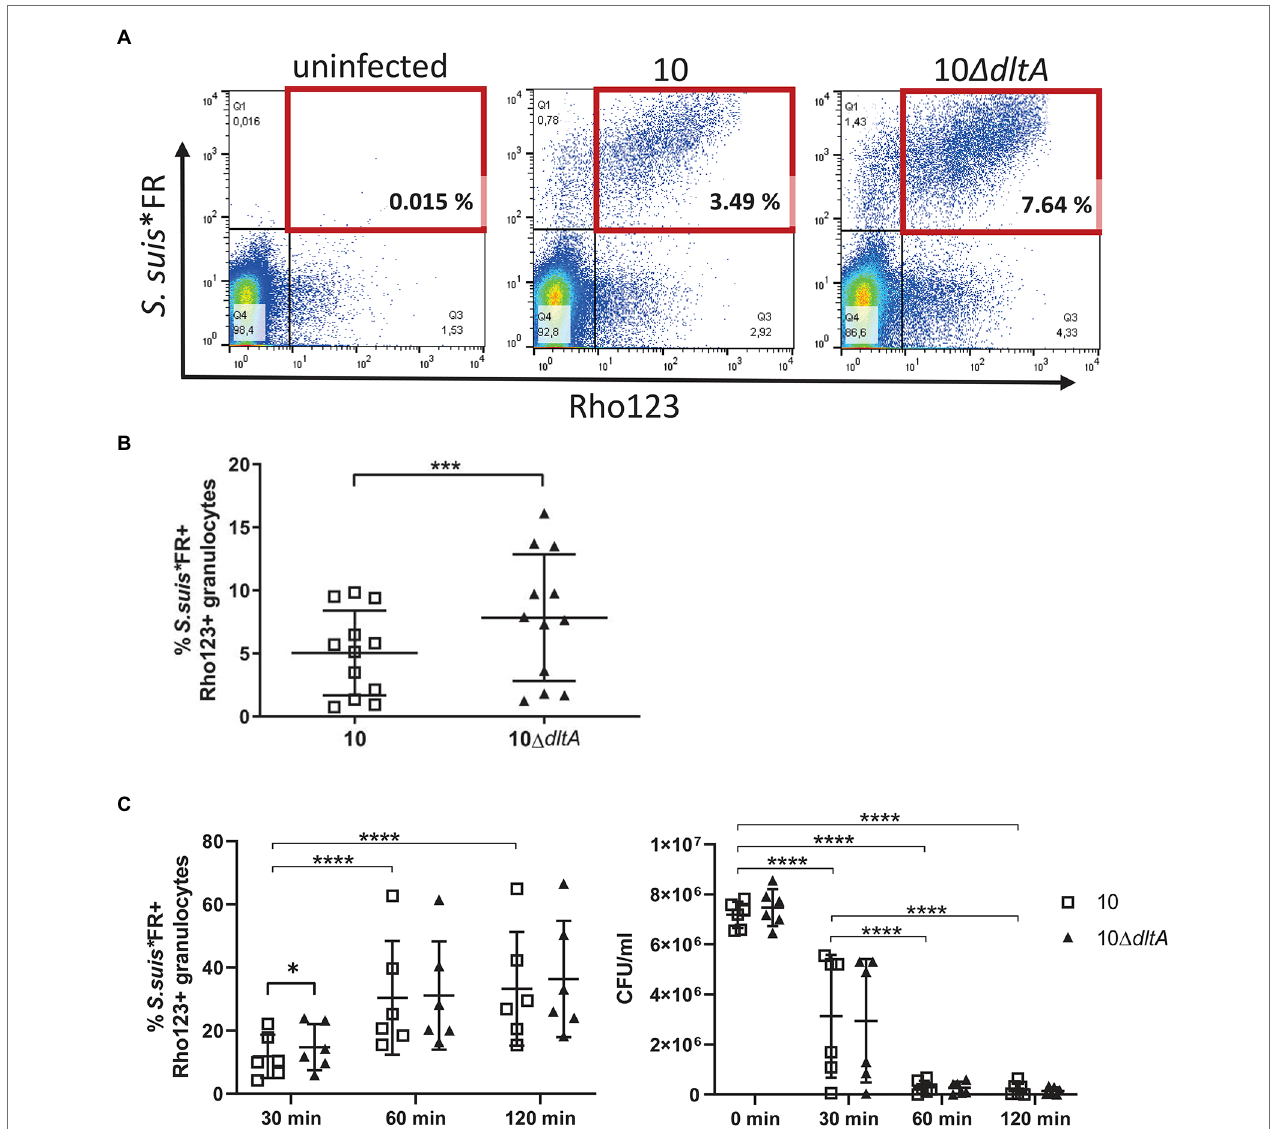
FIGURE 2 | D-alanylation of LTAs in Streptococcus suis reduces early association of S. suis with granulocytes and the proportion of granulocytes performing oxidative burst. Whole porcine blood was infected with Far Red (FR)-labeled S. suis at a concentration of 1 × 10 7 CFU/ml at 37 ° C for 15 min, followed by intracellular staining of reactive oxygen species (ROS) with dihydrorhodamine123 (Rho123) at 37 ° C for 10 min. After erythrocyte lysis, samples were analyzed by flow cytometry. While gating of granulocytes in whole blood is depicted in Supplementary Figure S4A , (A) demonstrates the gating strategy for double positive granulocytes (red square) in the blood of one piglet and (B) shows the % of granulocytes interacting with S. suis *FR (FR+) and producing ROS at the same time (Rho123+; n = 12). (C) Demonstrates the course of the association of streptococci with granulocytes that simultaneously show oxidative burst response over time, as well as the CFU of S. suis *FR in blood of six piglets. Error bars represent SDs. Paired t -test was performed for statistical analysis to compare wt and mutant samples in blood of the same animals (B,C) and repeated measures ANOVA followed by Tukeys multiple comparisons test was performed for each strain at different time points (C) . For clarity, significant differences between the time points are indicated for the wt samples only but are equally seen for the dltA mutant. ** p < 0.01, *** p < 0.001, and **** p <